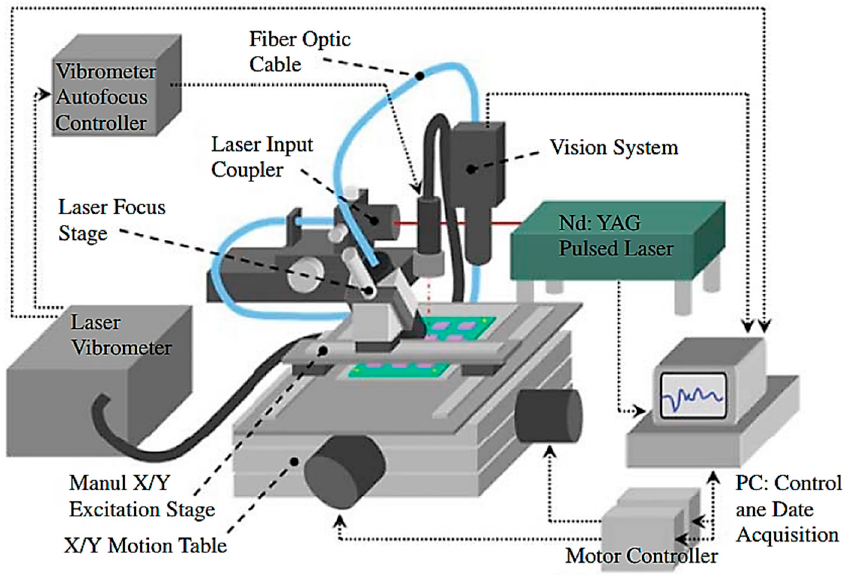
Figure 10. Schematic picture of a SAW inspection system for IC packaging (noncontact laser–based)